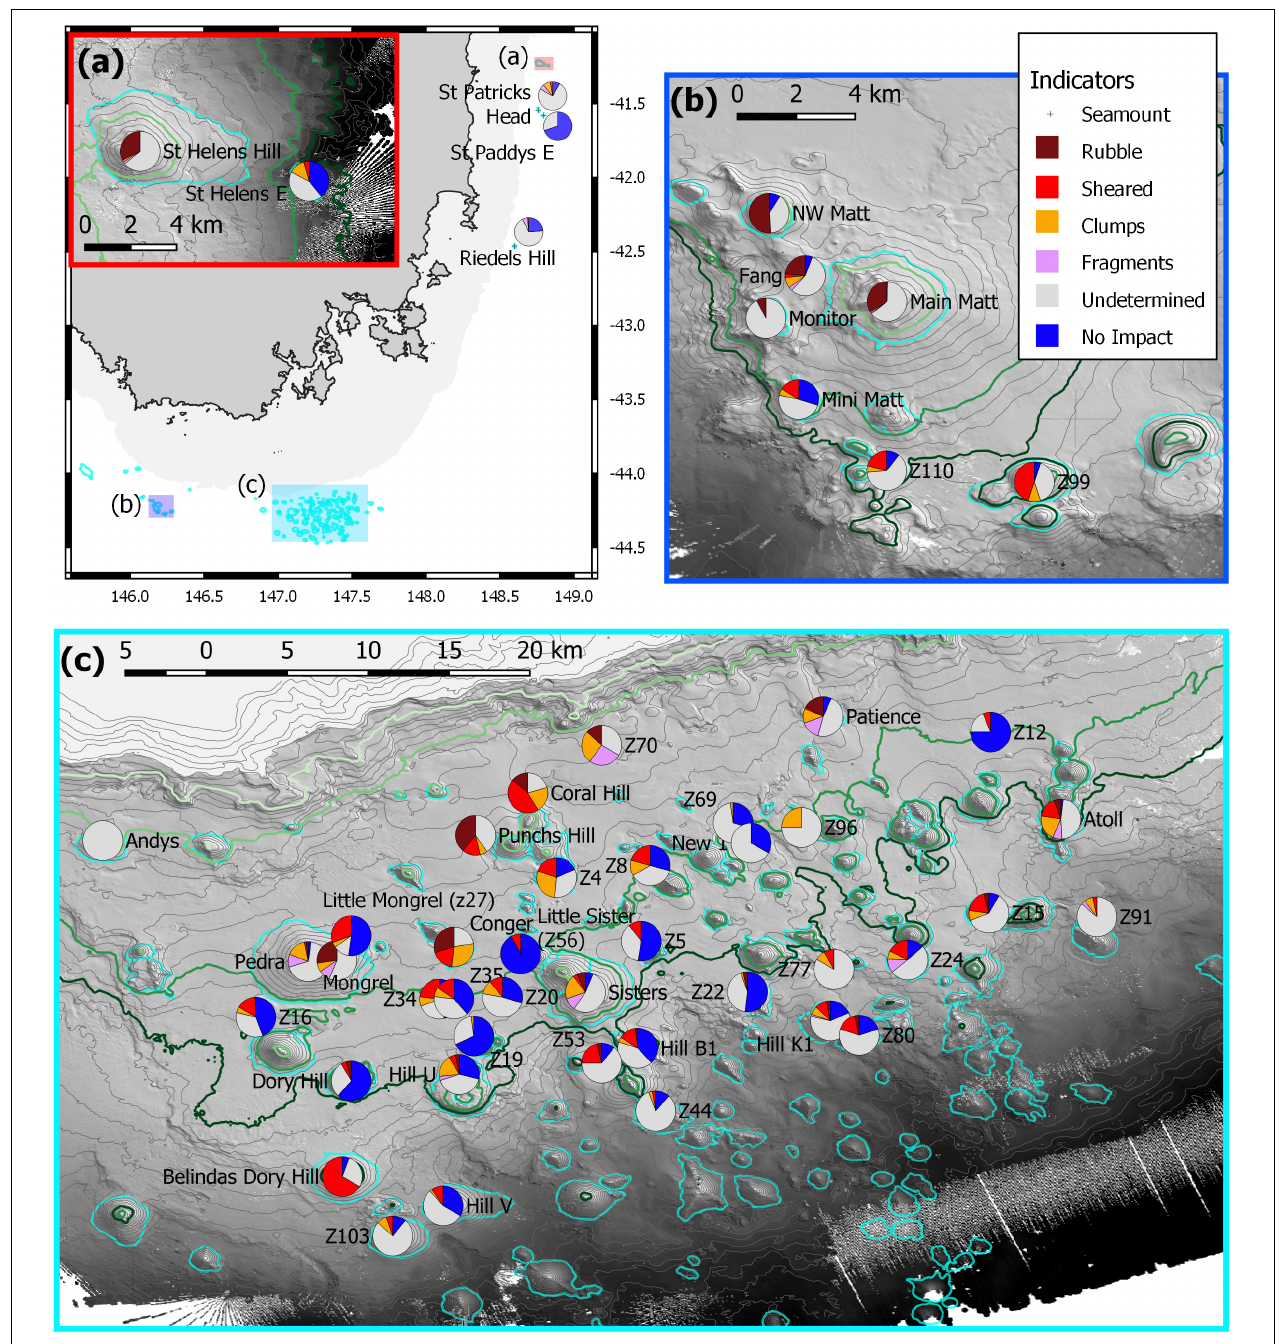
FIGURE 8 | The spatial distribution of the numeric impact indicators ( Figure 7 ) on individual seamounts. Contours are 50 m intervals with 650, 950, 1,350, and 1,500 m highlighted as light to dark green; the seamounts are outlined (cyan). (a) Overview map showing the 500 m depth mask and the relative locations of the three maps with inset of (a) the seamounts off St Helens; (b) sites in and adjacent to the Tasman Fracture AMP; (c) sites in and adjacent to the Huon